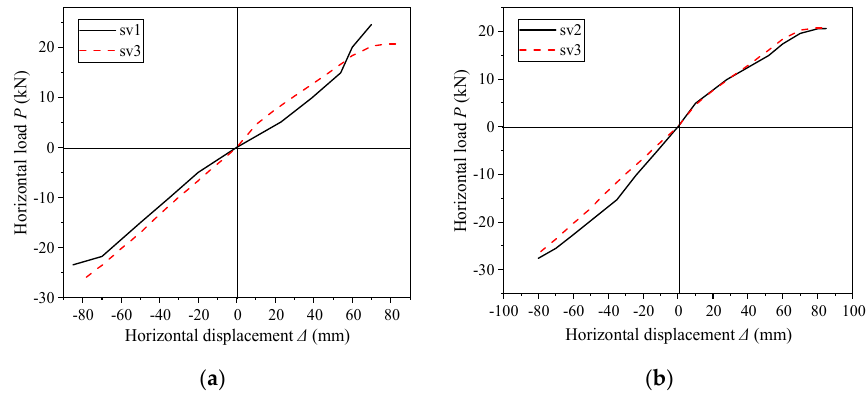
Figure 11. Envelope curves. ( a ) Specimen SV1 and SV3; ( b ) Specimen SV2 and SV3.